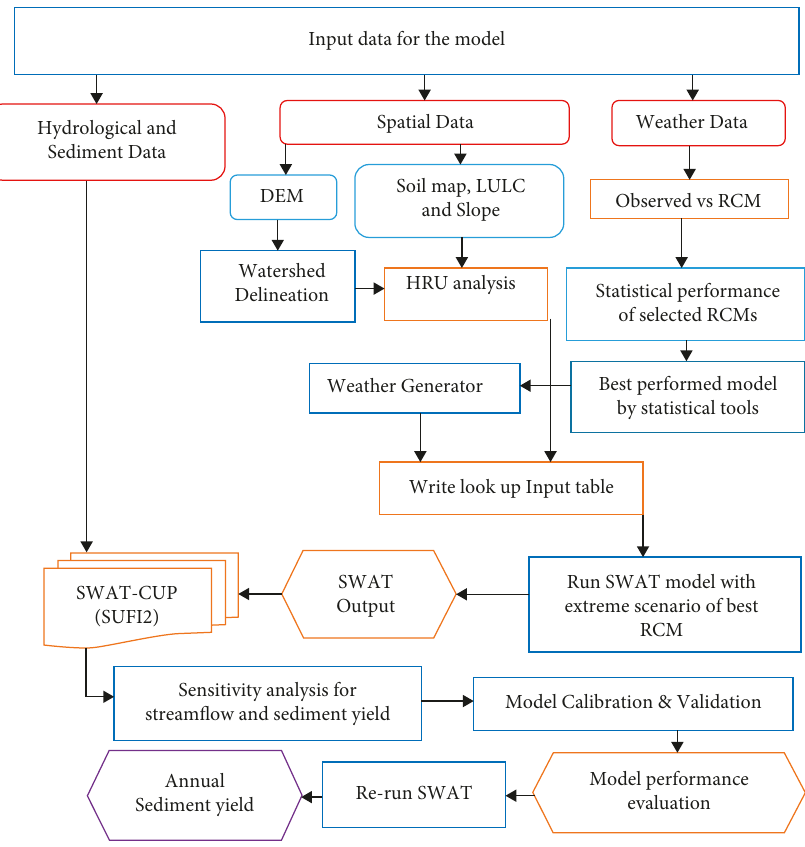
Figure 2: Flow chart of the